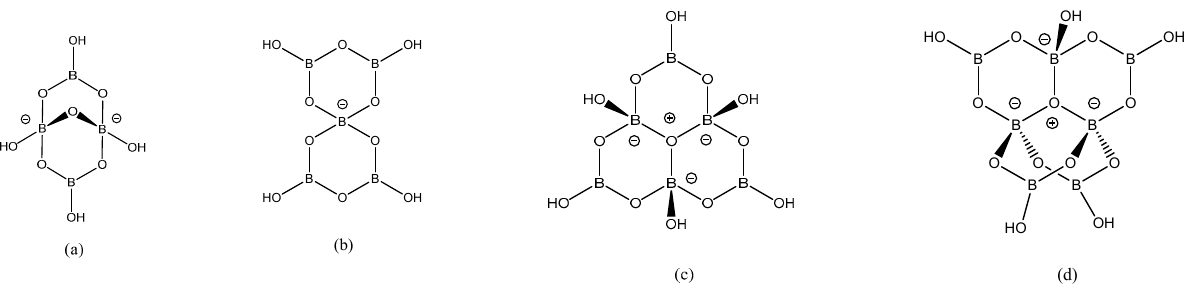
Figure 2. Drawings of the oxidoborate structures found in ( a ) 1 , ( b ) 2 – 5 , ( c ) 7 , 8 and ( d ) 6 .